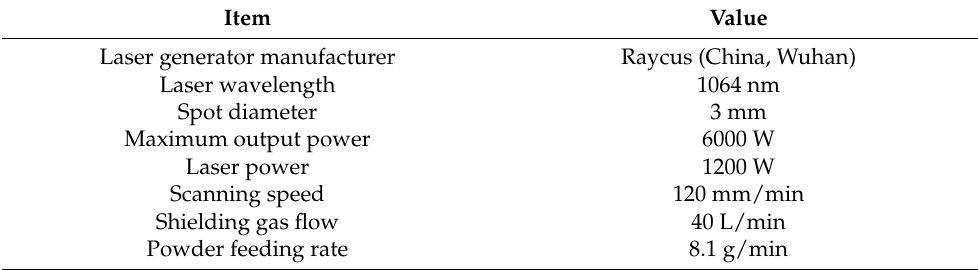
Table 2. Technical information pertaining to laser generator and optimum processing parameters for LMD process.